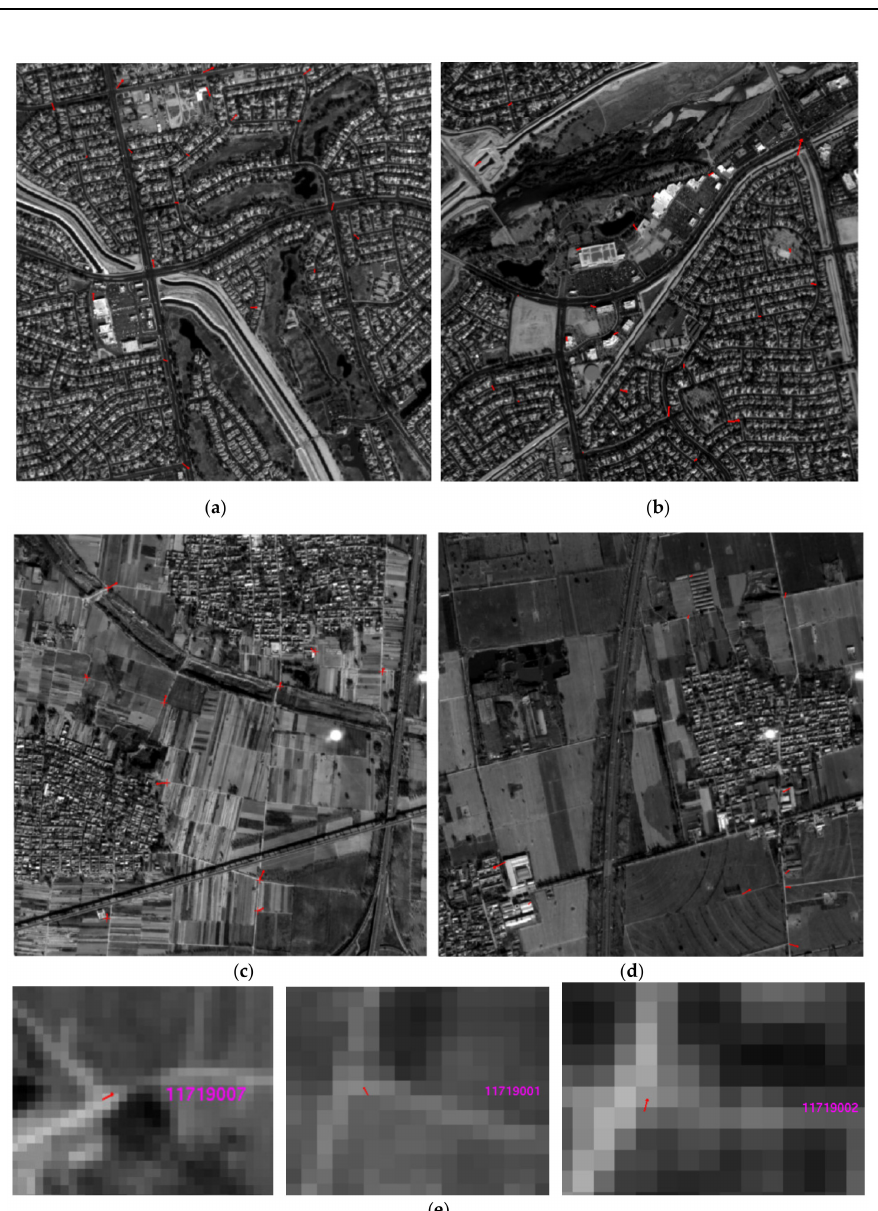
Figure 7. Residual distribution of checkpoints on the footprint images. ( a ) RMSE of Image 661: 0.95 pixel. ( b ) RMSE of Image 664: 0.87 pixel. ( c ) RMSE of Image 719: 0.98 pixel. ( d ) RMSE of Image 721: 0.98 pixel. ( e ) Details of some checkpoints’ residuals on image